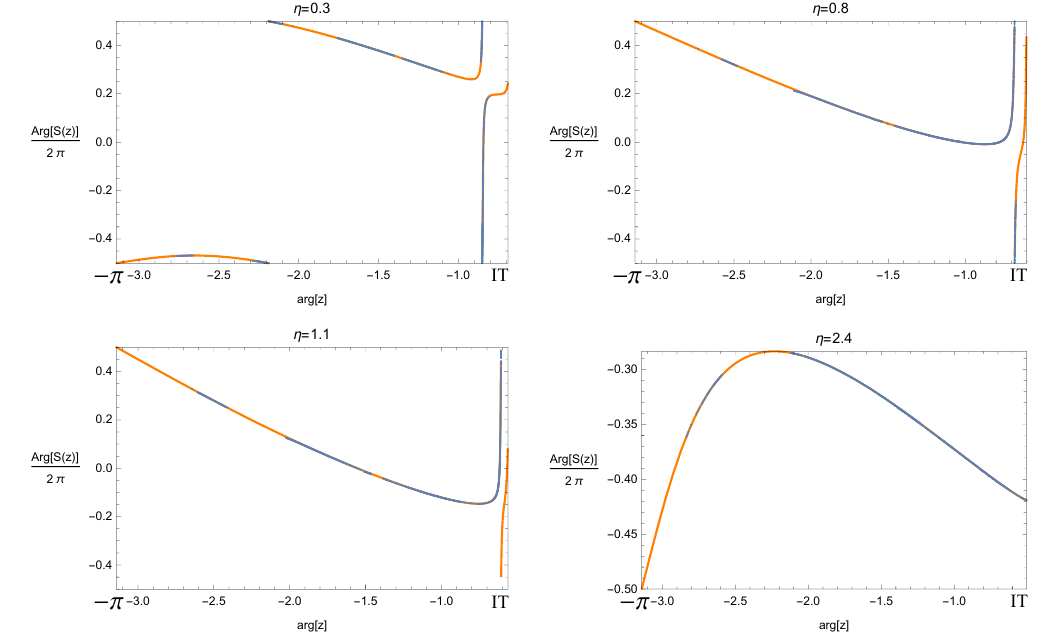
Figure 14. The scattering phase as a function of arg( z ) in the elastic regime, obtained from TFFSA via Luscher’s method, is shown in blue. The orange curve represents the fit to an analytic function built out of a presumed number of CDD zeros and an exponential factor in the form of (2.25), multiplied by the known CDD pole factors (determined by the masses of stable particles).